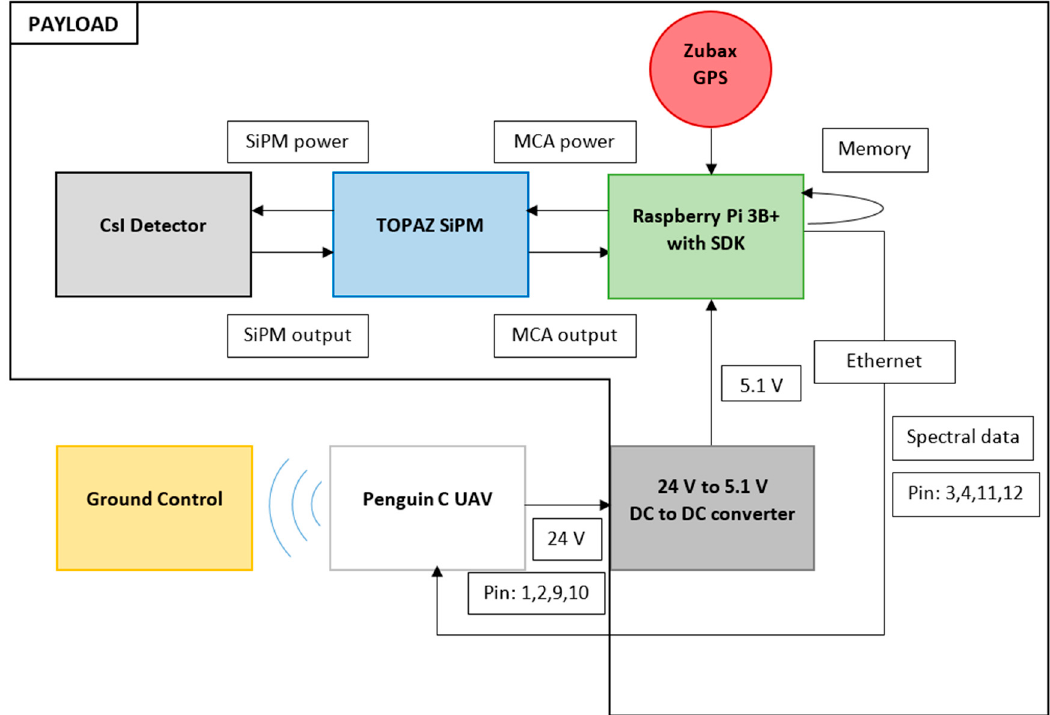
Figure 6. Schematic of the detector system and connection to the Penguin C UAV for remote communication.